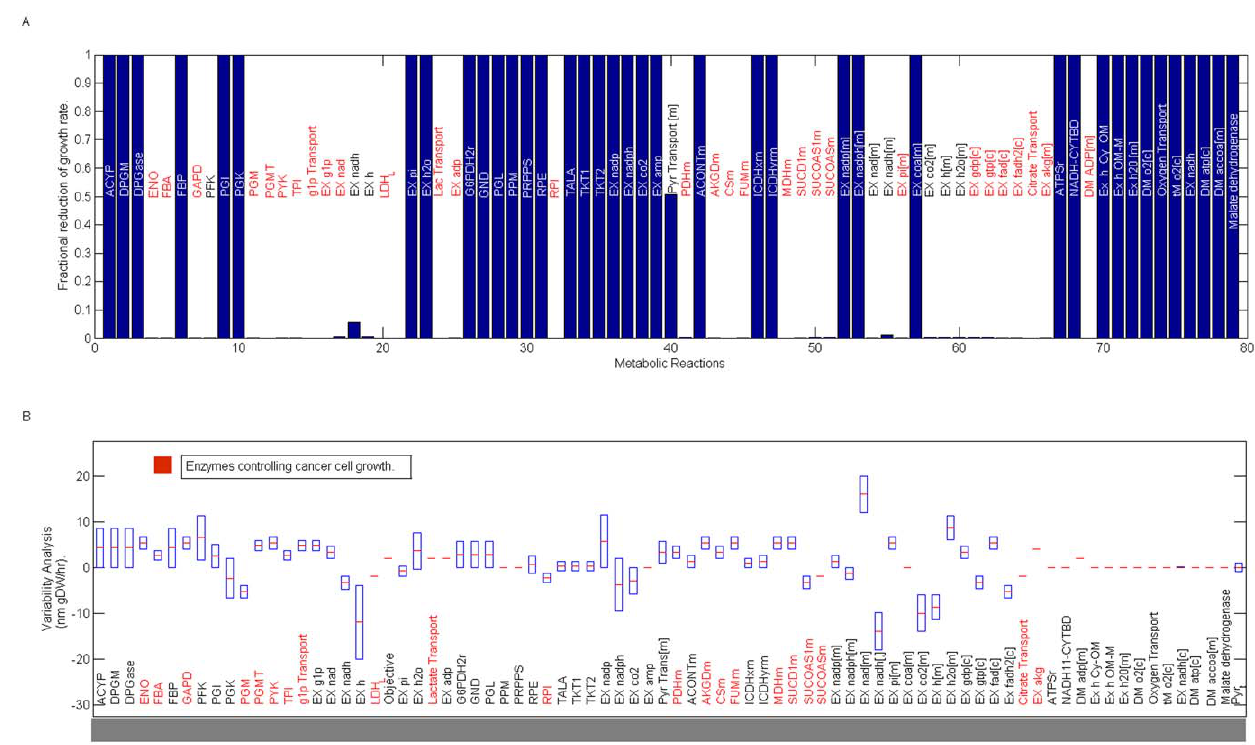
Figure 3. Flux Variability and Enzyme essentiality on metabolic reactions. To identify those reactions that could have a pivotal role in cancer growth rate, flux variability and enzyme essentiality analysis were accomplished over all the reactions included in the reconstruction. In panel (A) , the metabolic reactions whose deletion produces a significant reduction on growth rate are highlighted in red. Those reactions that ensure a low variability and high essentiality constitute 27% of the complete metabolic reconstruction and these appear in red in panel (B) . Exchange and sink reactions were excluded from this analysis. Abbreviation code: Enolase (ENO) , glyceraldehyde-3-phosphate dehydrogenase(GAPD) , phosphoglucomutase (PGMT) , pyruvate kinase (PYK) , triose-phosphate isomerase (TPI) , lactate dehydrogenase (LDH) , ribose-5-phosphate isomerase (RPI) , pyruvate dehydrogenase (PDHm) , 2-oxoglutarate dehydrogenase (AKGDm) , cytrate synthase (CSm) , Fumarate hydratase (FUMm) , malate dehydrogenase (MDHm) , succinate dehydrogenase (SUCD1m) , succinyl-CoA synthetase (SUCOAS)